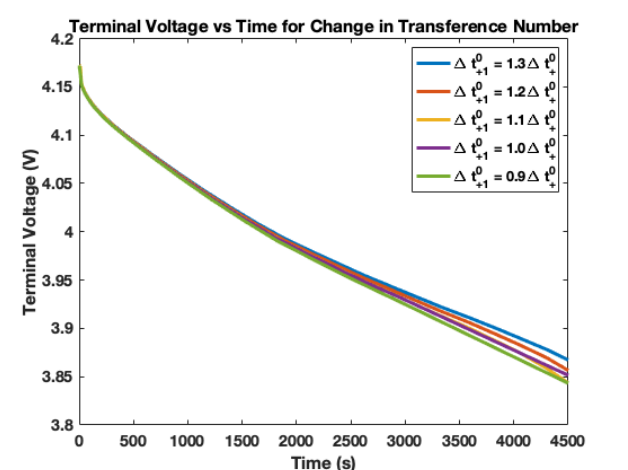
Figure 10. Terminal voltage vs. time for change in transference number from 1.3 to